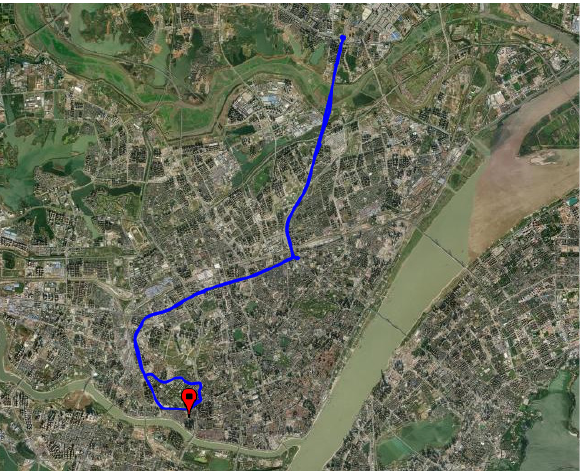
Figure 17. Vehicle experiment environment.